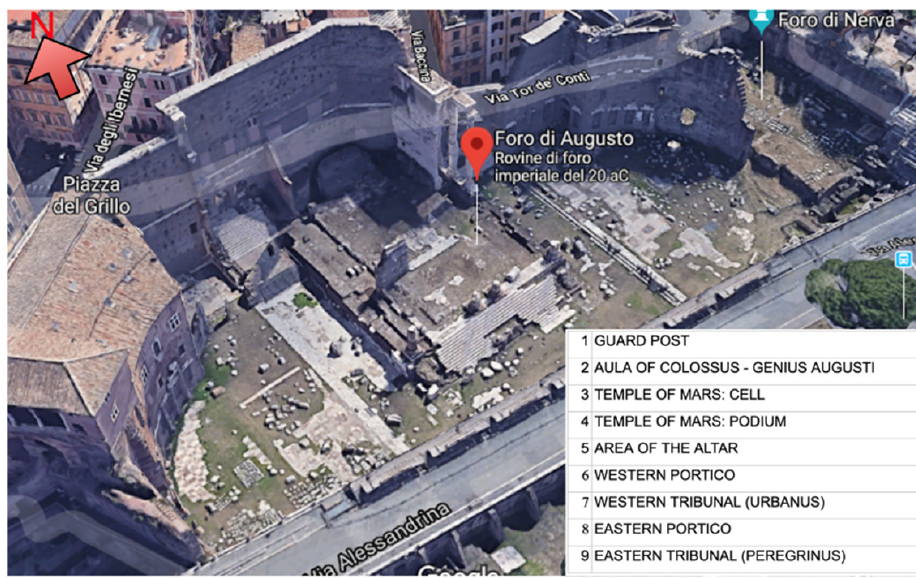
Figure 5. Testers were asked to locate game places in an aerial image of the archaeological site. Impact of Meaningfulness. RQ2 investigated the connection between conceptual knowl- edge and meaningfulness. The experiment did not lead to clear results, although we did observe engagement and embodiment in the written reports of the multimodal game